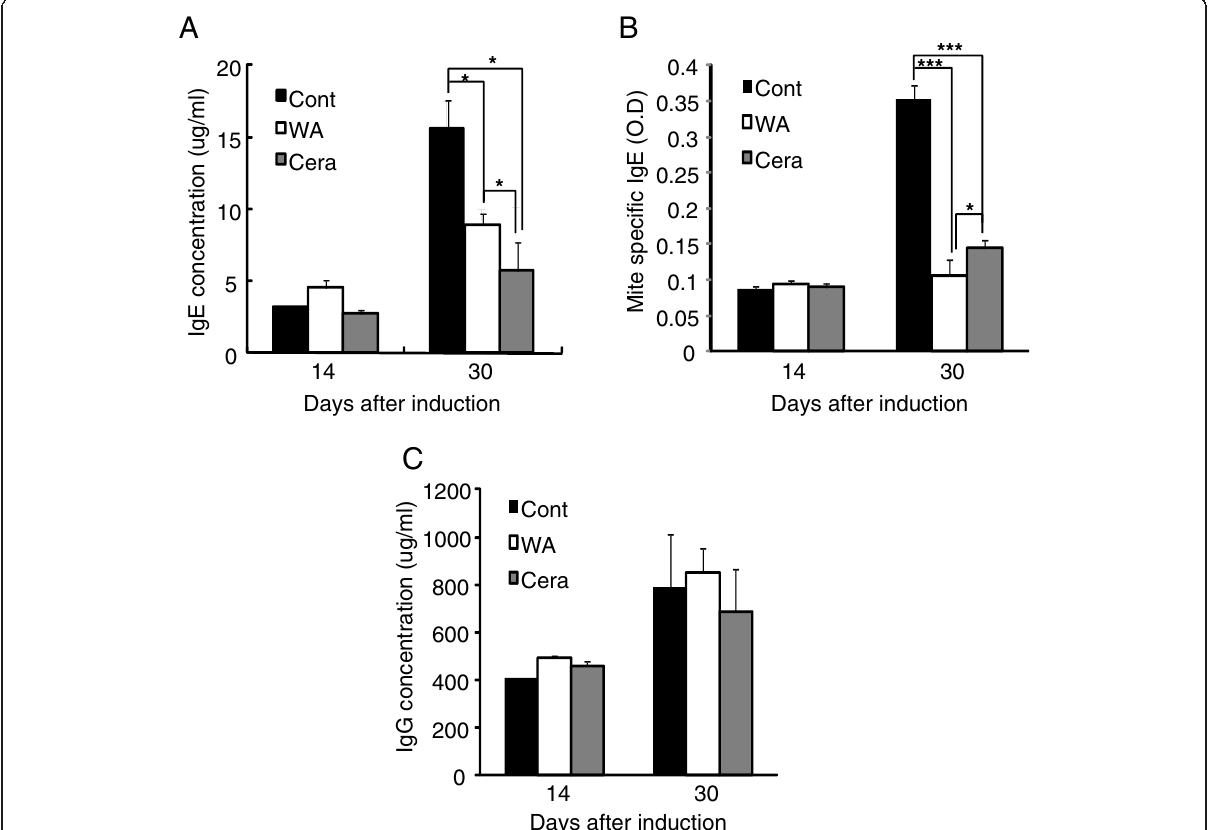
Figure 4 Water soluble extract of P. linteus (WA) reduces IgE levels in AD induced mice. After 2 and 4 weeks of AD induction, sera were obtained from each group, and the levels of total IgE ( A ), antigen (mite)-specific IgE ( B ) and total IgG ( C ) were measured by ELISA. Error bars indicated S.D. One (*), two (**) and three asterisk (***) indicates P<0.05, P<0.005, P<0.001, respectively. Data are representative of three independent